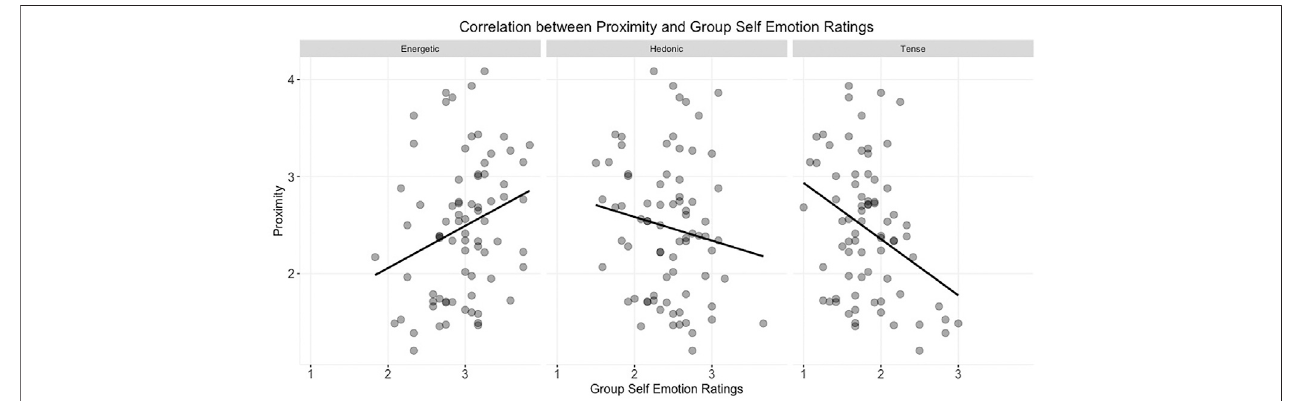
FIGURE 3 | Correlation between proximity and group self-ratings on emotional states.